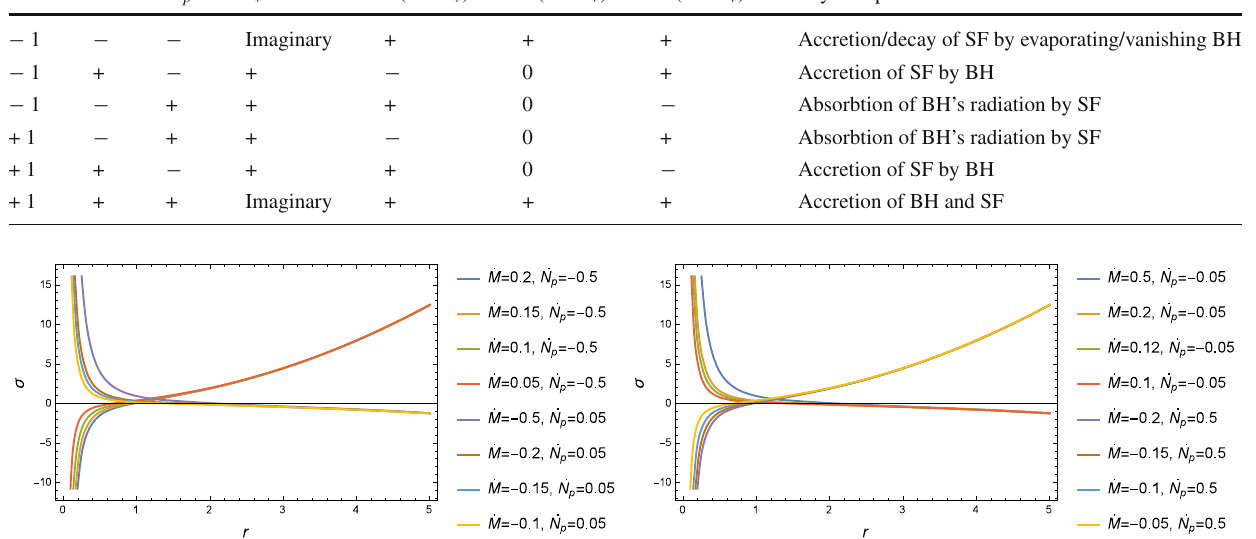
Fig. 18 Left figure: the radiation-accretion density σ versus the dis- tance r for some typical constant ˙ M and ˙ N p values for (cid:5) = − 1 in the phantom background. In the four upper cases, the accretion density is an increasing function from negative to positive values. In the four lower cases, the radiation density is a decreasing function from positive to negative values. Then, for a dynamical phantom background, if the condition | ˙ N p ( u ) | (cid:11) | ˙ M ( u ) | is not met, the positive energy condition is violated in some regions of spacetime. Right figure: the radiation-